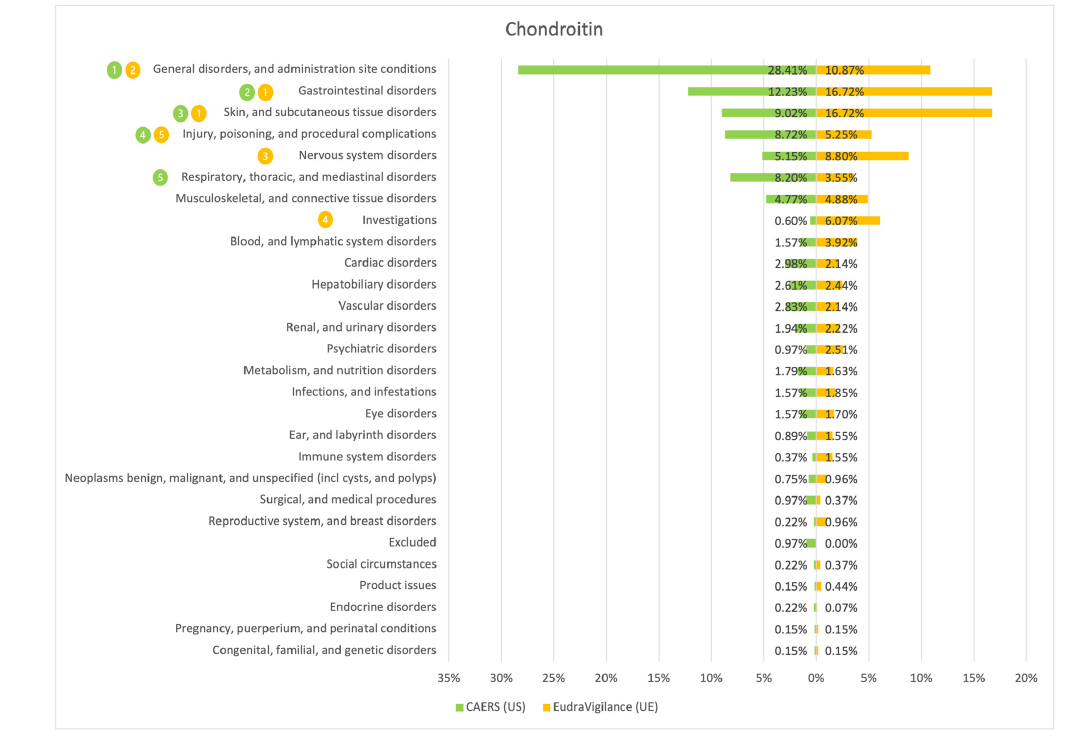
Figure 6. Summary of the frequency of reporting side effects of Chondroitin in the US and EU registers. Data marked in green refer to the CAERS (US) database and yellow to the EudraVigilance (UE) database. Numbers 1–5 present the most commonly reported categories of adverse effects in descending order.